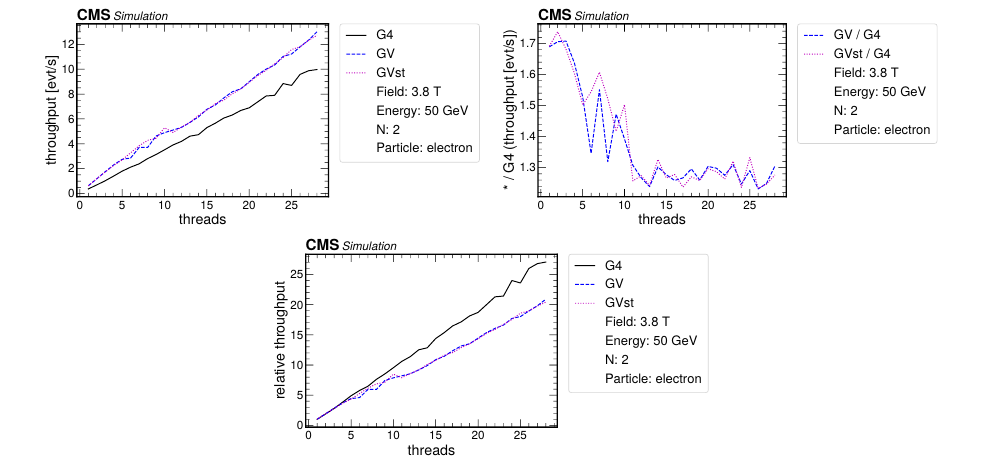
Figure 5. Top left: throughput in events per second for G eant 4 and G eant V, versus the number of threads. Top right: the ratio of G eant V to G eant 4 throughput, versus the number of threads. Bottom: The relative throughput for multiple threads compared to a single thread for G eant 4 and G eant V. In all plots, the item “GVst” indicates G eant V in single-track mode, as explained in the text.